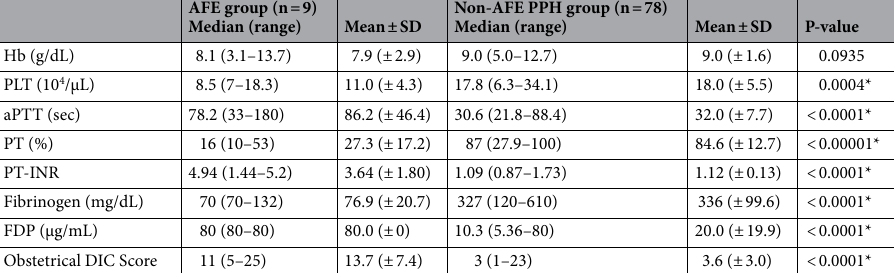
Table 2. Comparison of haemostatic parameters at onset for each group. Hb haemoglobin concentration (normal range 11.6–14.8 g/dL), PLT platelet count (normal range 15.8–34.8 10 4 /μL), aPTT activated partial thromboplastin time (normal range 24–39 s), PT (%) prothrombin time activity percentage (normal range 80–120%), PT-INR International Normalized Ratio of Prothrombin Time (normal range 0.90–1.10), FDP fibrin degradation products (normal range 0.00–4.99 μg/mL), DIC disseminated intravascular coagulation, AFE amniotic fluid embolism, SD standard deviation, PPH postpartum haemorrhage. * denotes significant